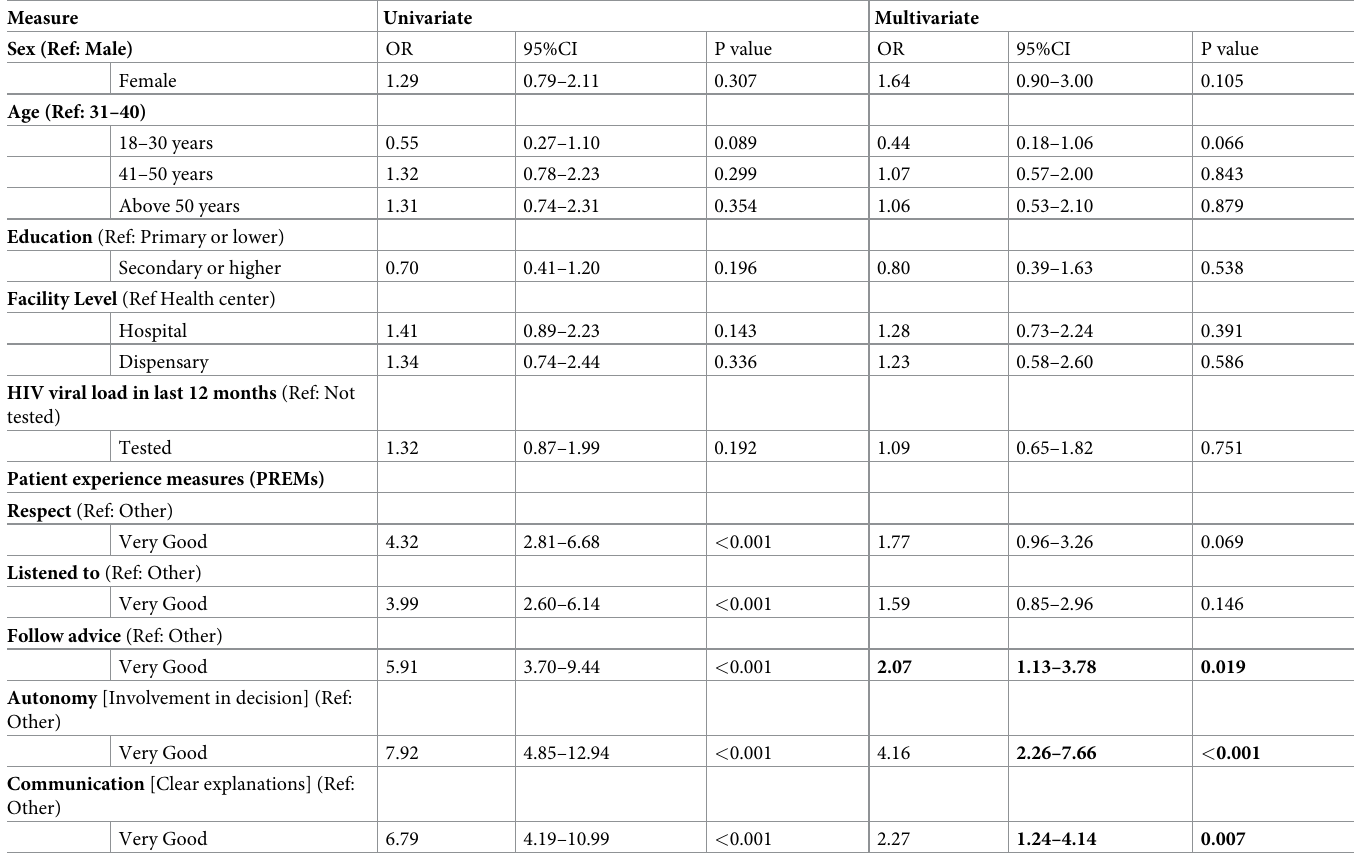
Table 3. Logistic regression of association of patient factors and PREMs with VL testing meeting participants’ health goals. Measure Univariate